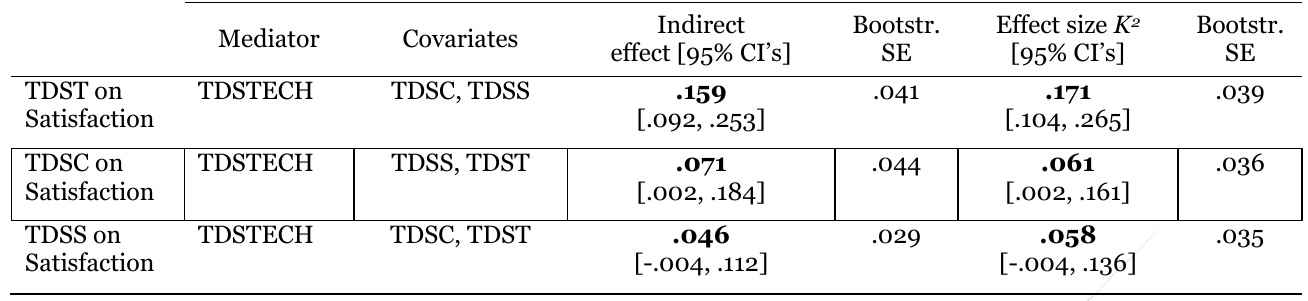
Summary of Three Mediation Models With Covariates